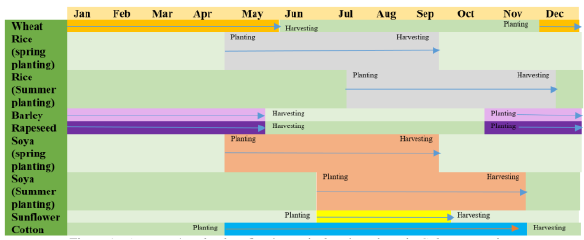
Figure 1. Agronomic calendar of major agricultural products in Golestan